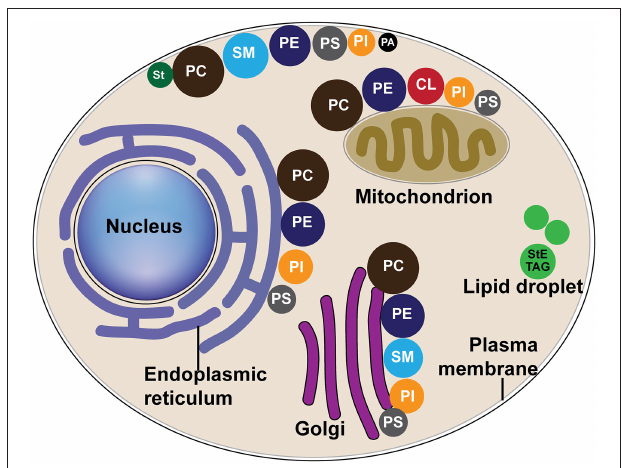
FIGURE 3 | The distribution of major lipids in host organelle membranes. Different colors of circles represent different lipid classes, and the size of circles represent the percentage of one class of lipid to the total phospholipids, as modified from van Meer et al. (2008). CL, cardiolipin; PA, phosphatidic acid; PC, phosphatidylcholine; PE, phosphatidylethanolamine; PS, phosphatidylserine; PI, phosphatidylinositol; SM, sphingomyelin; St, sterol; StE, steryl ester; TAG,